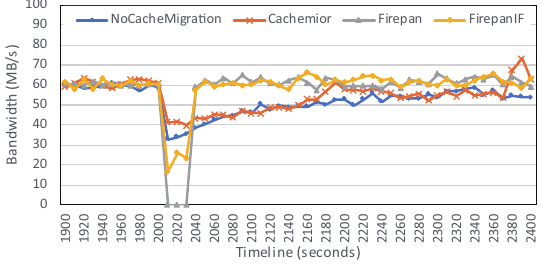
Figure 7. Bandwidth before and after VM migration with NoCacheMigration, Cachemior, Firepan, and